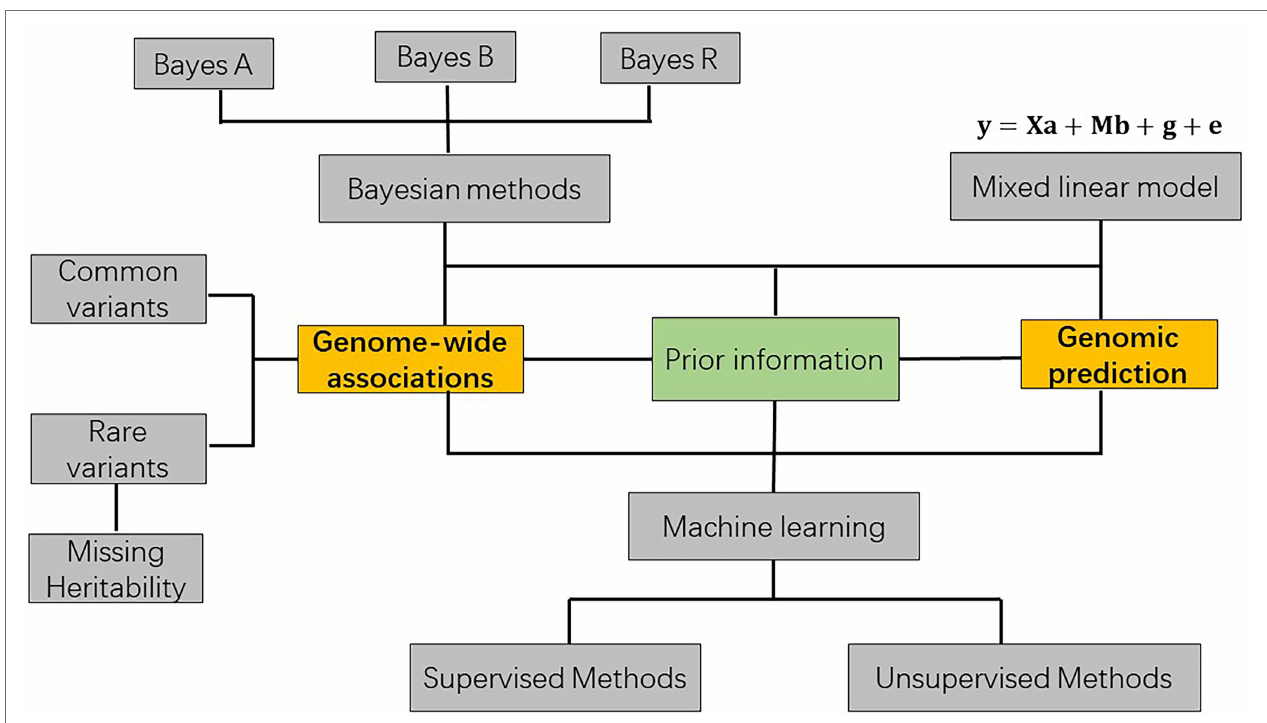
FIGURE 1 | The basic statistical methods and theories for agricultural